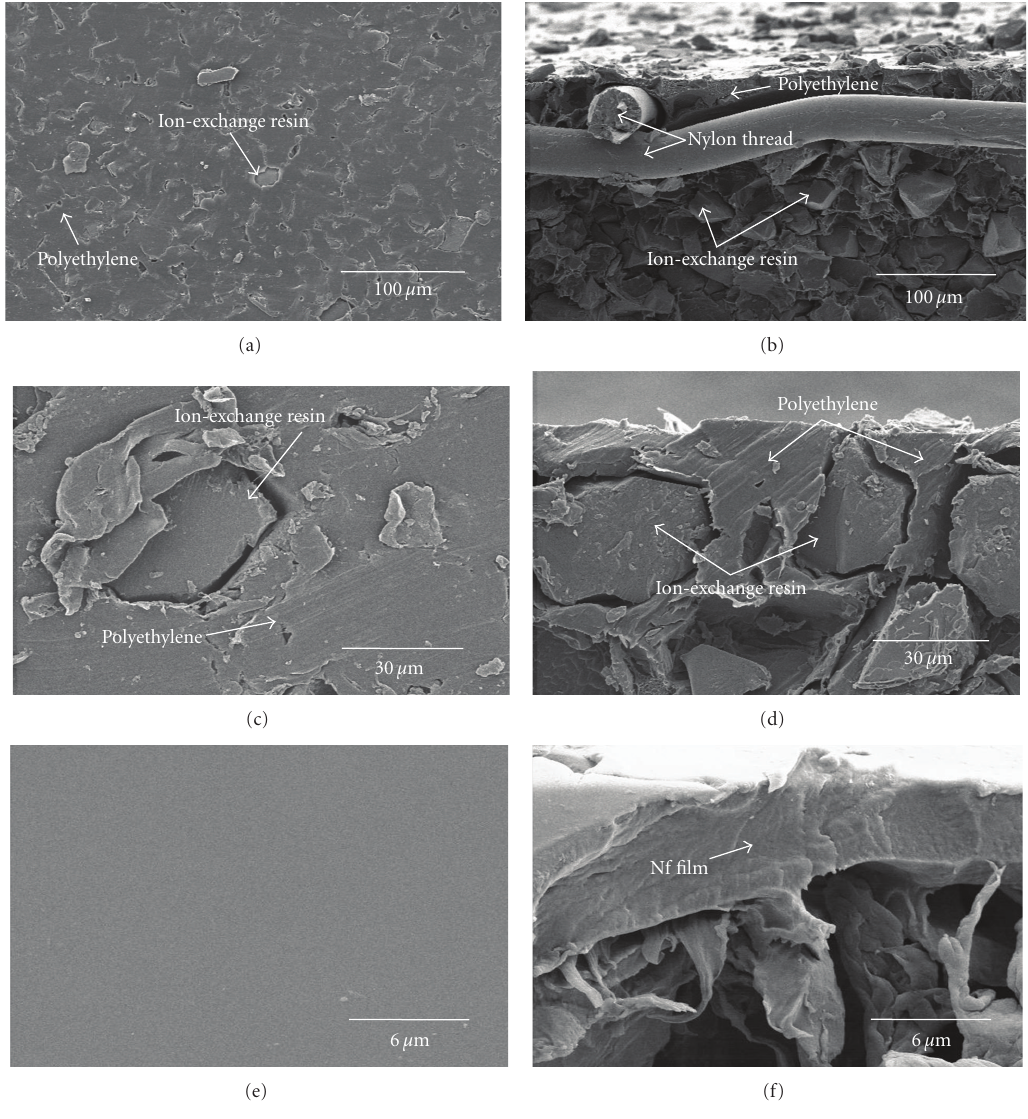
Figure 1: SEM images of the surface (a, c, and e), the cross sections (b, d, and f) of a MK-40 (a, b, c, and d), and a MK-40/Nf (e, f) ion- exchange